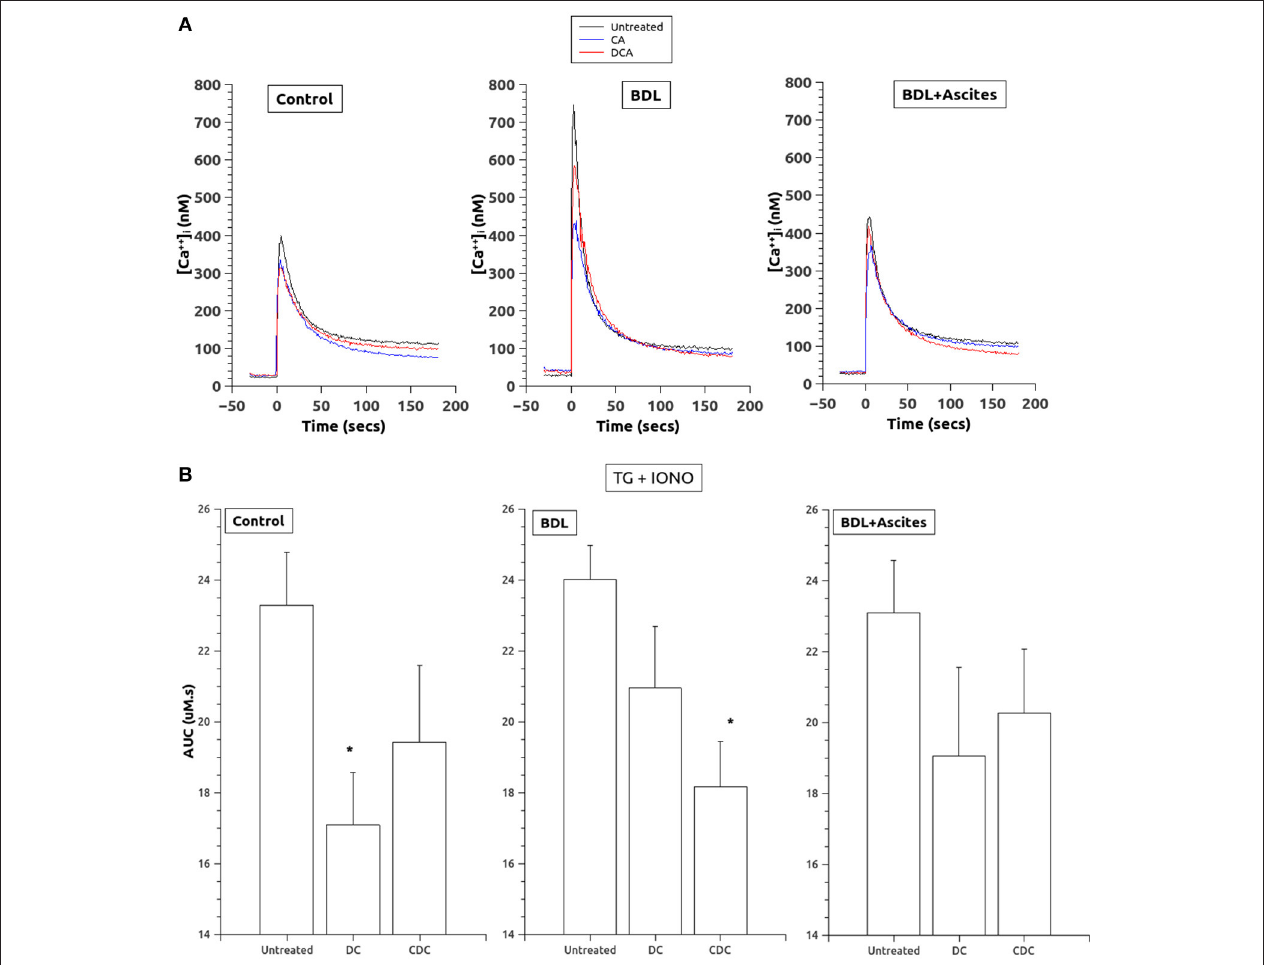
FIGURE 3 | (A) Changes in [Ca 2 + ] i after thapsigargin and ionomycin administration (added at time 0) to allow for estimation of total calcium in intracellular stores. Data were obtained in untreated platelets and after incubation with CA or DCA (100 µ M). (B) Area under the curve of the calcium changes after thapsigargin and ionomycin to estimate total calcium in intracellular stores. Data were obtained in untreated platelets and after incubation with CA or DCA (100 µ M). Data are means ± S.E.M. * p < 0.05 vs.